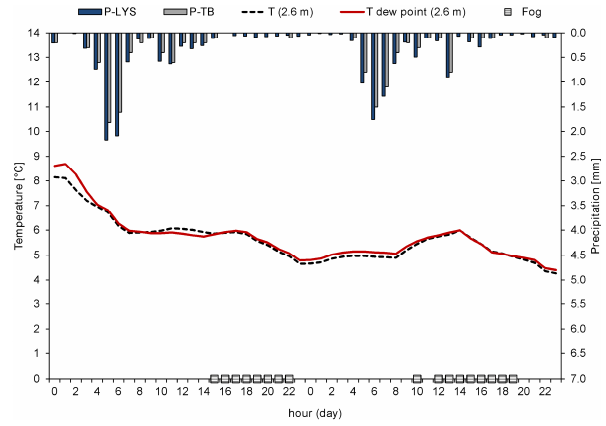
Figure 6. Precipitation, temperature, and dew point temperature from 5 to 6 May 2012 at the Rollesbroich site. The fog symbol indi- cates the hours with fog occurrence (detected with installed surveil- lance system) for the investigated period.